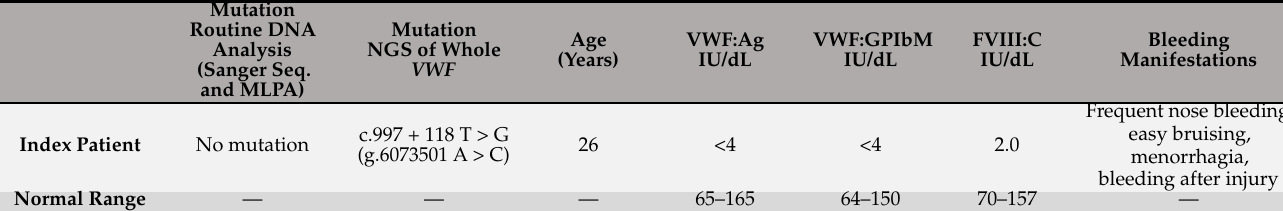
Table 1. Phenotypic characteristics and genetic data of the index